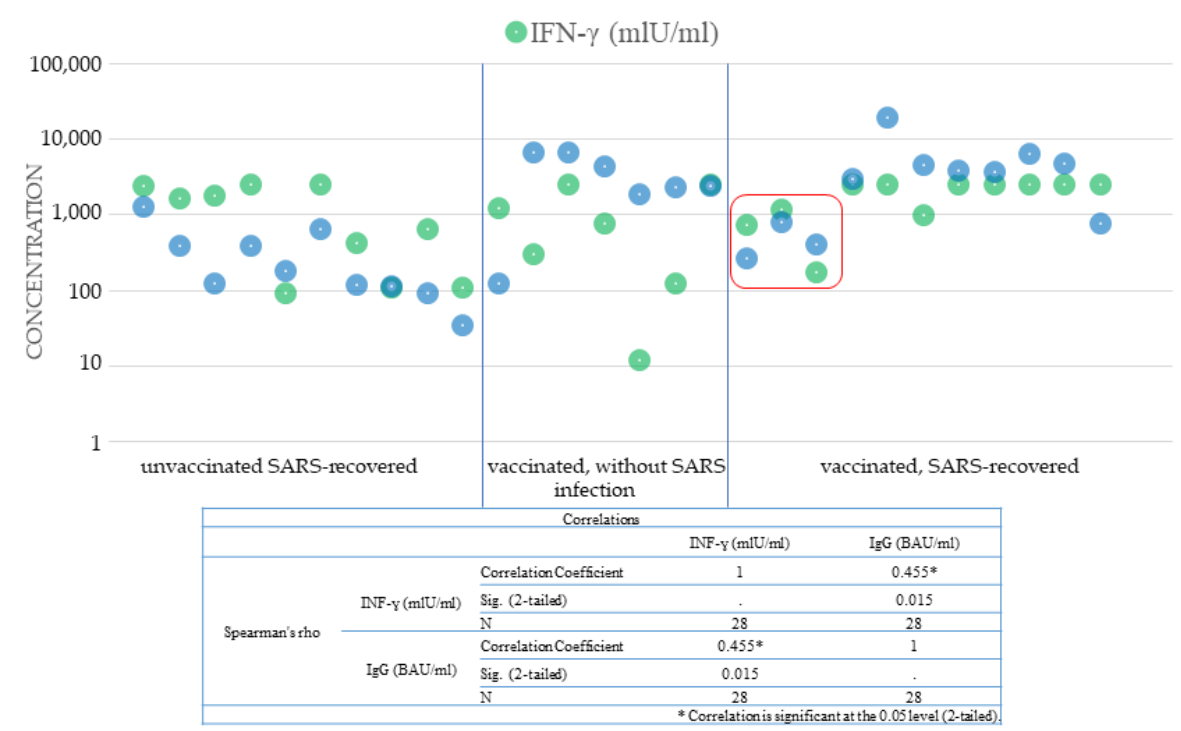
Figure 4. Comparison of anti-SARS-CoV-2 IgG antibody titers against S1 protein and interferon-gamma concentrations released after stimulation of Th lymphocytes in 28 individuals (patients who recovered from SARS. vaccinated persons without previous viral infection. and vaccinated SARS-recovered). The red frame marks 3 people who were infected with the SARS-CoV-2 virus despite vaccination.